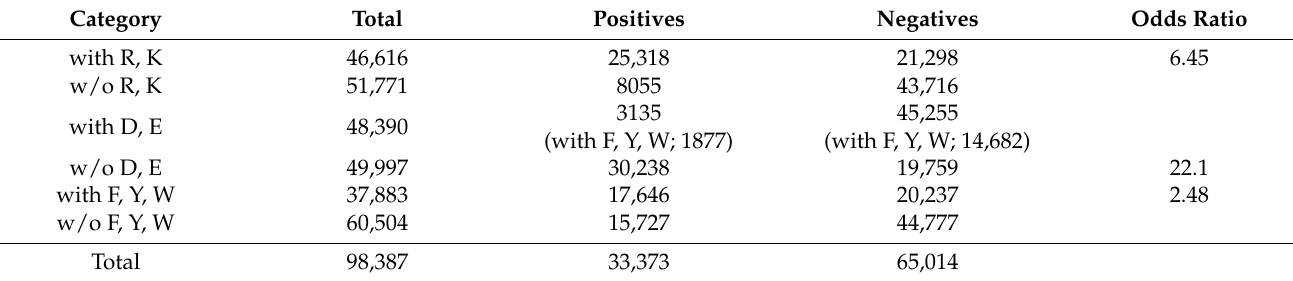
Table 3. Amino acid (AA) distribution of positives and negatives predicted by RF modeling.